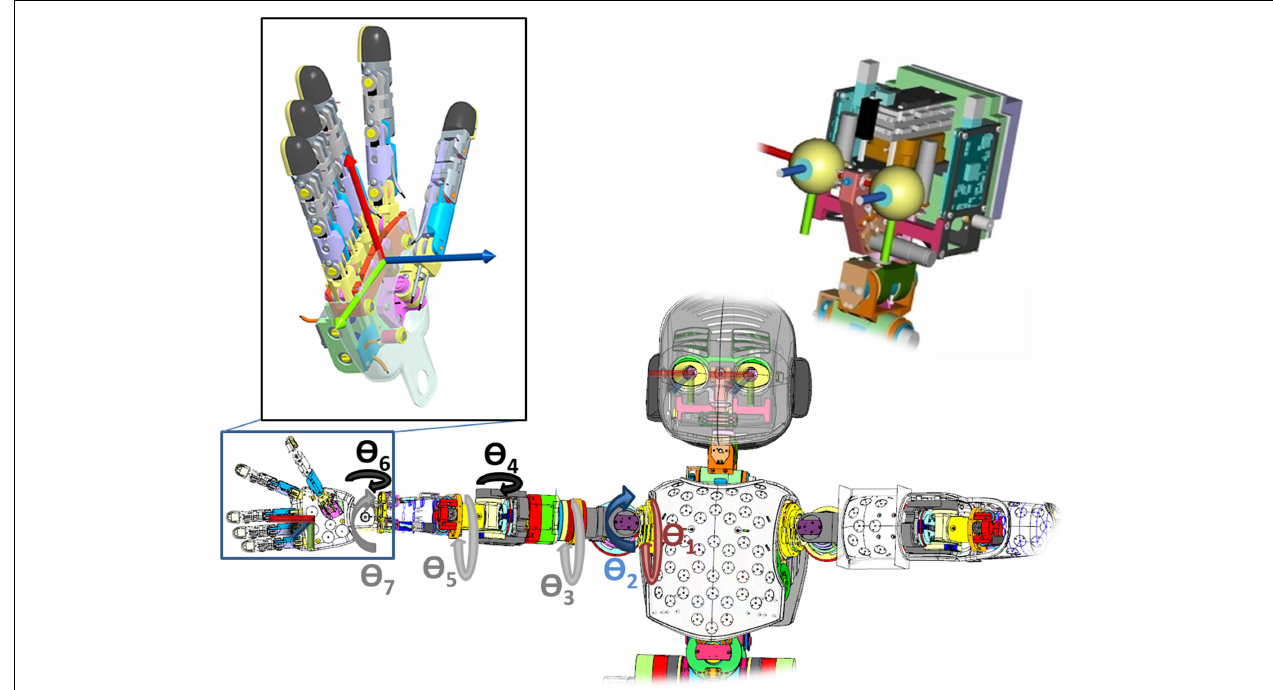
FIGURE 2 | The end-effector’s pose (palm of the hand) is a function of the joints angles . Axis color notation: x-red; y-green; z-blue. (For a more detailed description visit: http://wiki.icub.org/wiki/ICubForwardKinematics). Best seen in